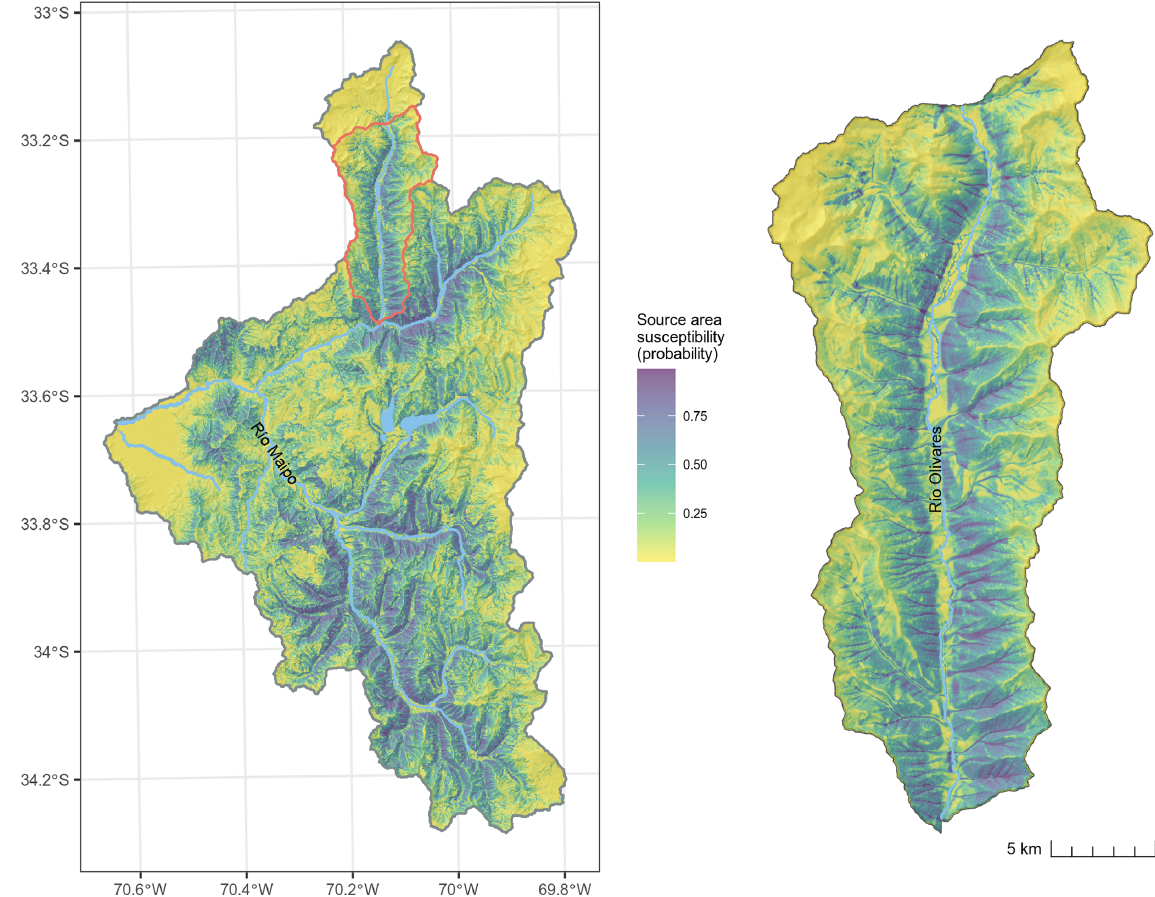
Figure 4. Map of the debris-flow source-area prediction based on a